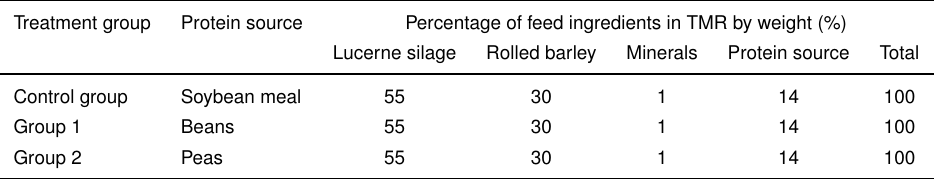
Table 2. Percentages of feed ingredients comprising the total mixed ration (TMR) by weight, as fed, used for three groups of pigs as part of the feed trial.